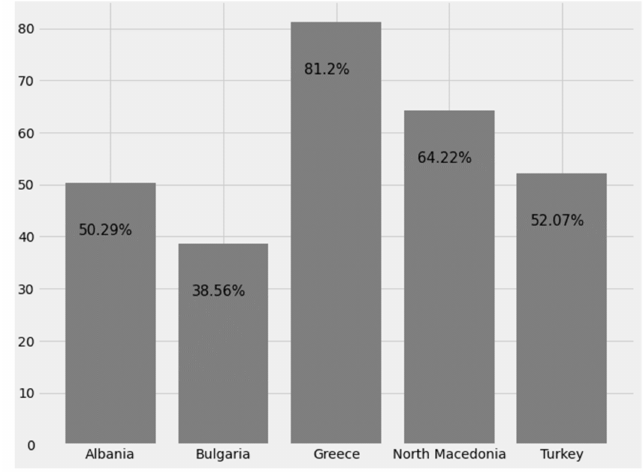
Figure 27. Recovery rates by country.